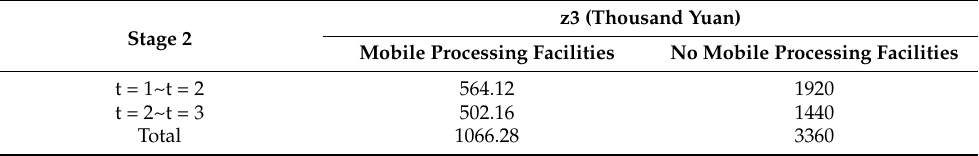
Table 9. The transfer cost at second stage with or without mobile processing